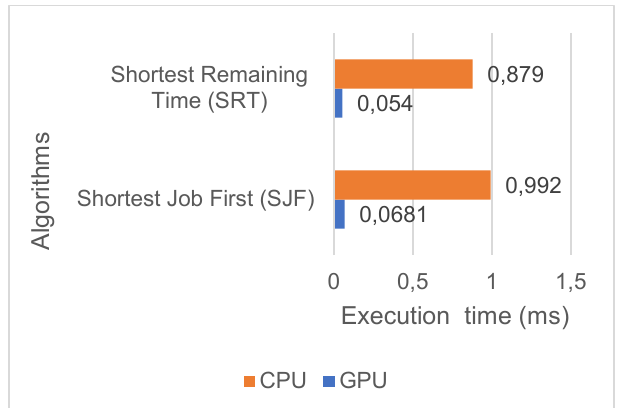
Figure 2. The execution time obtained by implementing two algorithms on GPU and CPU The results of Table 1 and Figure 2 show that for the same data from the processors of two algorithms, SRT and SJF, we have: